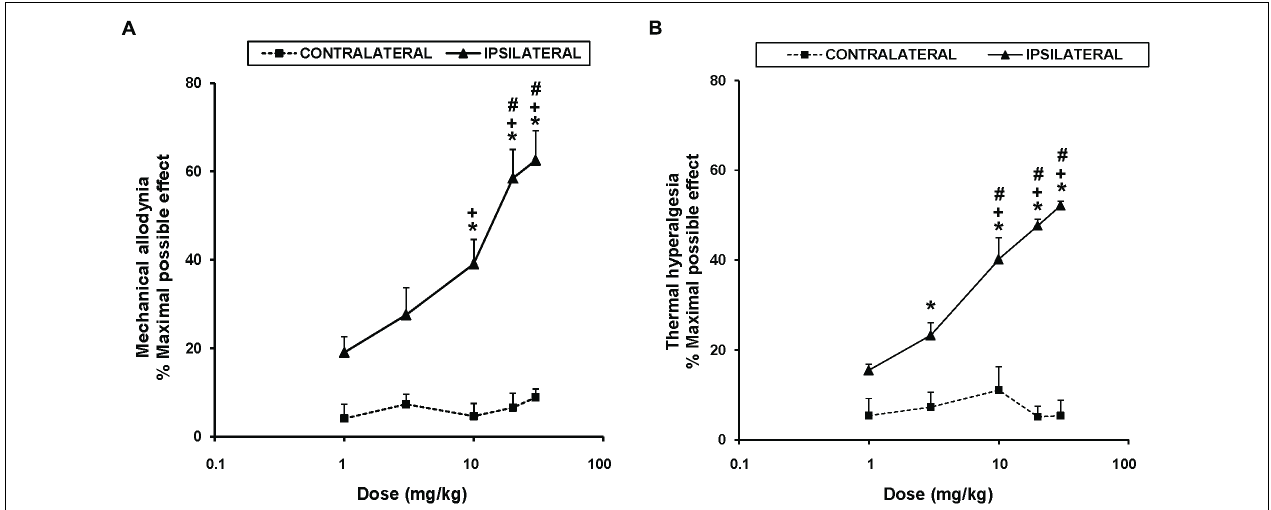
FIGURE 1 | Effects of UFP-512 on the mechanical allodynia and thermal hyperalgesia induced by CFA. The effects of acute intraperitoneal administration of different doses (logarithmic axis) of UFP-512 on the mechanical allodynia (A) and thermal hyperalgesia (B) induced by CFA in ipsilateral (continuous lines) and contralateral hind paws (discontinuous lines) are shown. UFP-512 was administered 1 h before testing. In both panels and for each dose assessed, ∗ indicates significant differences vs. their respective effects in the contralateral paw, + indicates significant differences vs. the effect produced by 1 mg/kg of UFP-512 in the ipsilateral paw and # indicates significant differences vs. the effect produced by 3 mg/kg of UFP-512 in the ipsilateral paw ( P < 0.05; one-way ANOVA, followed by the Student–Newman–Keuls test). In both tests, data are expressed as mean values of maximal possible effect (%) ± SEM; n = 6 animals per dose.